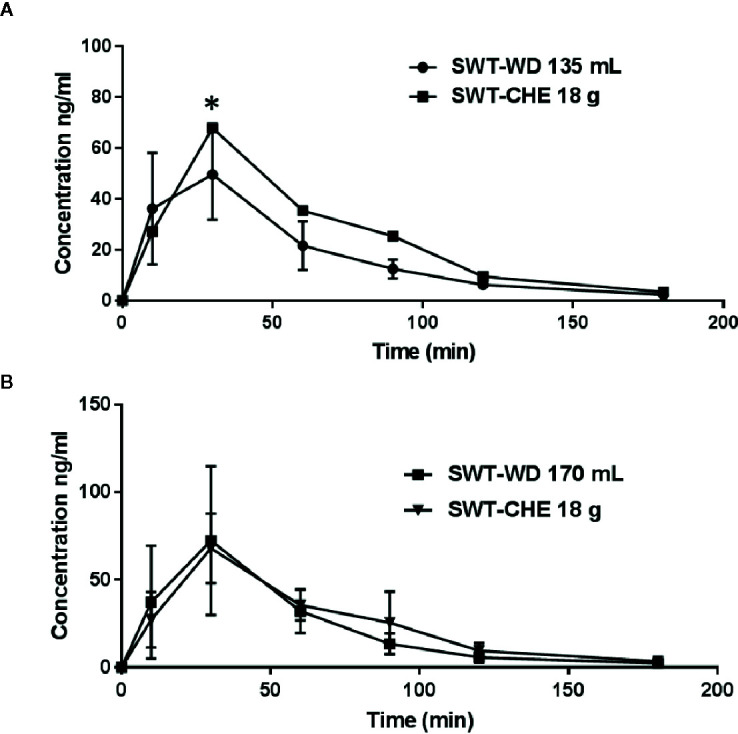
Area under the curve (AUC)-time curve of ferulic acid in the subject’s serum. (A) Group with 135 mL of the Si-Wu-Tang (SWT)-water decoction (WD) and 18 g of the SWT-concentrated herbal extract (CHE) and (B) the group with 170 mL of SWT-WD and 18 g of SWT-CHE.